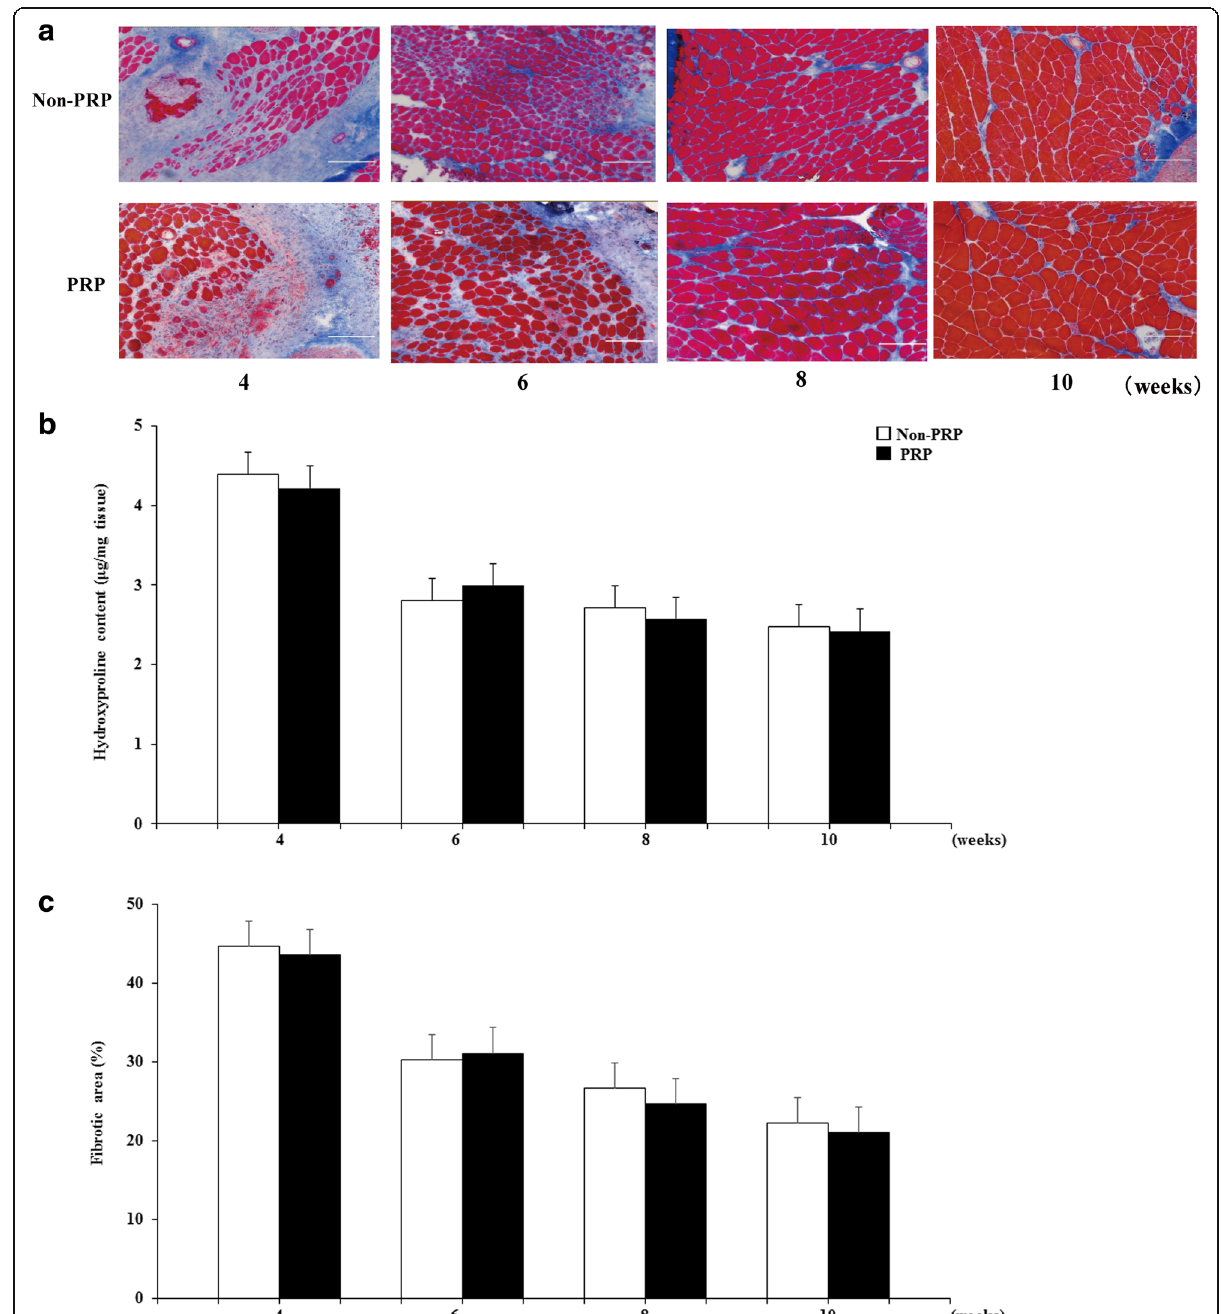
Fig. 4 a Representative cross-sections of GC muscles stained with Masson ’ s trichrome in the non-PRP and PRP groups at 4, 6, 8, and 10 weeks after osteotomy (Bar, 100 μ m). b The ratio of the fibrotic area to the total muscle cross sectional area in the GC muscles of the two groups. Data represent mean±SEM ( n =10/group/week). c Total hydroxyproline content in the GC muscles of the two groups. Data represent mean±SEM ( n